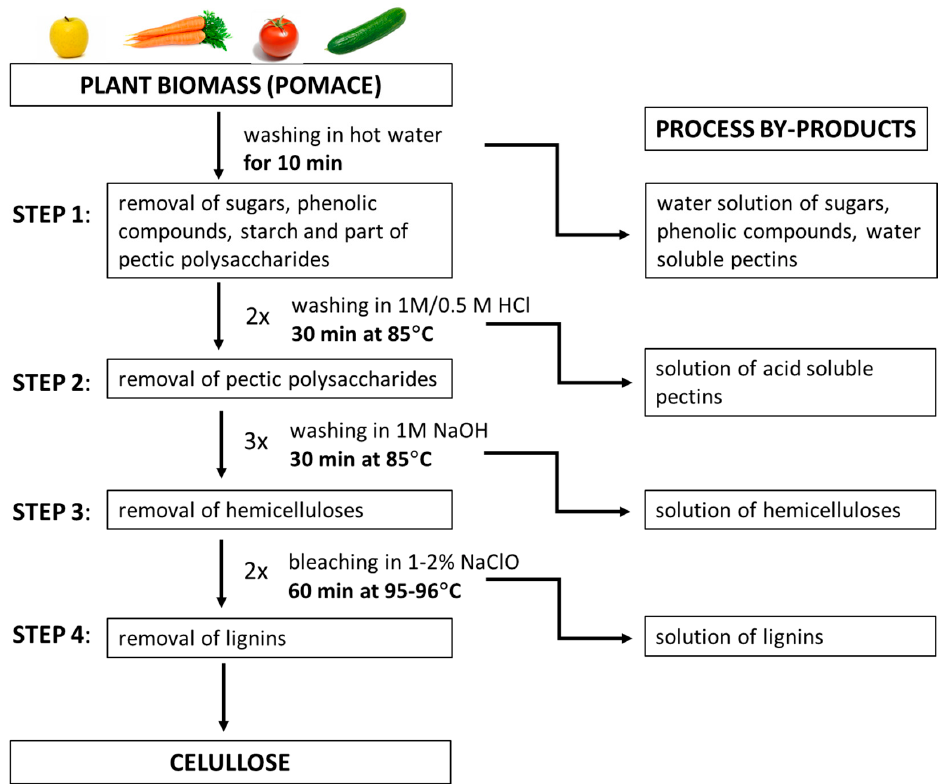
Figure 1. The flow chart of pomace fractioning process (patent application) [42].